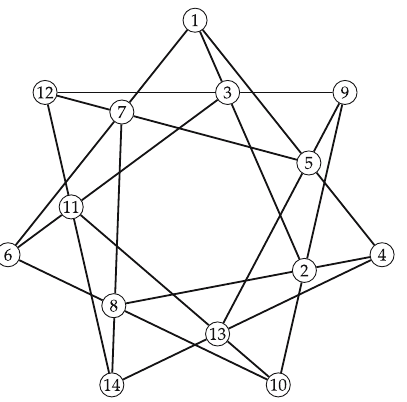
Figure 3: The cyclic 14 3 - con fi guration whose automorphism group order is 14.